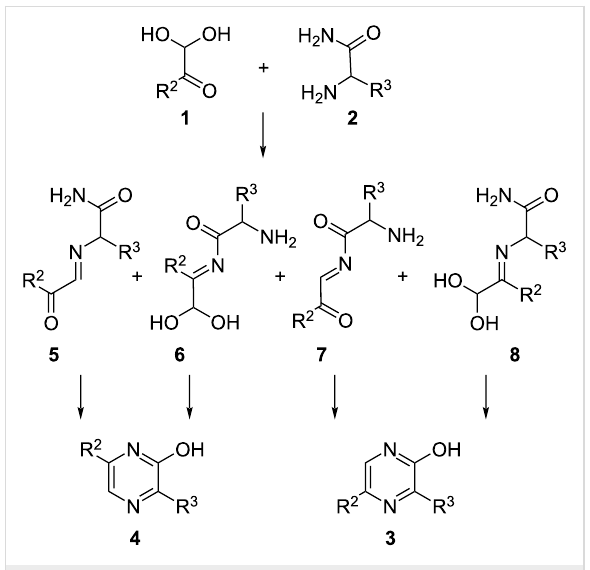
Scheme 2: Four hypothetical reaction